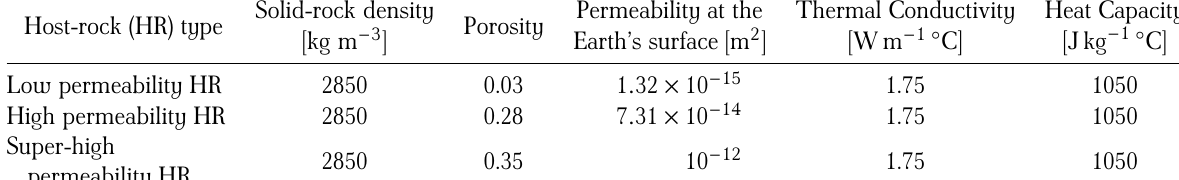
Table 2: Overview of rock physical properties used in the modelling performed for this study. In order to simplify the model input parameters, we use three rock types only, i.e. a low-permeability, a high-permeability, and a super-high permeability host-rock. Densities are based on a bulk dry density that assumes a solid matrix density of 2900 kg m − 3 . Porosities are derived from the range of rocks measured by Eggertsson et al. [2020], thermal conductivity is from Robertson and Peck [1974] and based on dry basalt; heat capacity from Heap et al. [2020b].